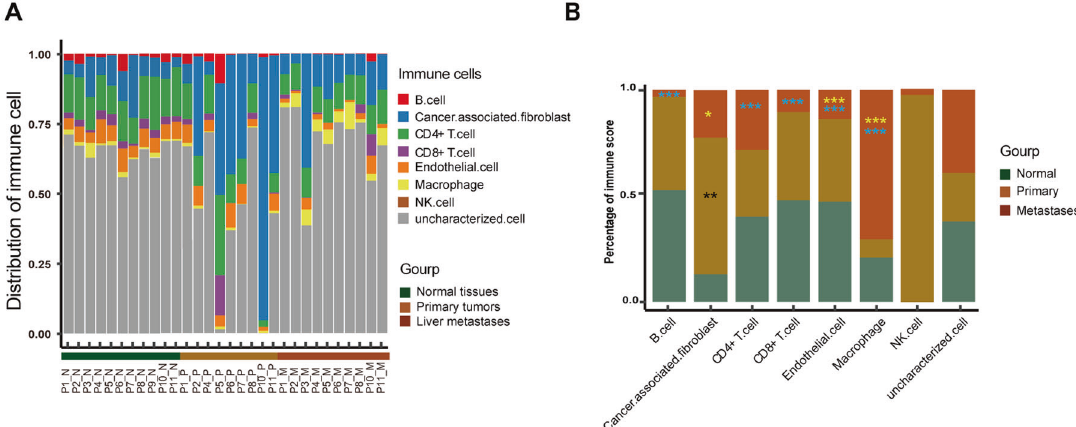
Fig. 6 The distribution of immune cell in various stages of CRC. A The distribution of B cell, cancer associated fi broblast, CD4 + T cell, CD8 + T cell, endothelial cell, macrophage, NK Cell and uncharacterized immune cell in normal, CRC primary tumor and liver metastasis. B The difference of immune in fi ltration in various stages of CRC. Yellow asterisk (*) indicates the signi fi cant difference between metastasis and primary, blue asterisk (*) indicate the signi fi cant difference between normal and metastasis, black asterisk (*) indicates the signi fi cant difference between normal and primary tumors. * p < 0.05, ** p < 0.01, *** p < 0.001. Cell Death Discovery (2021)